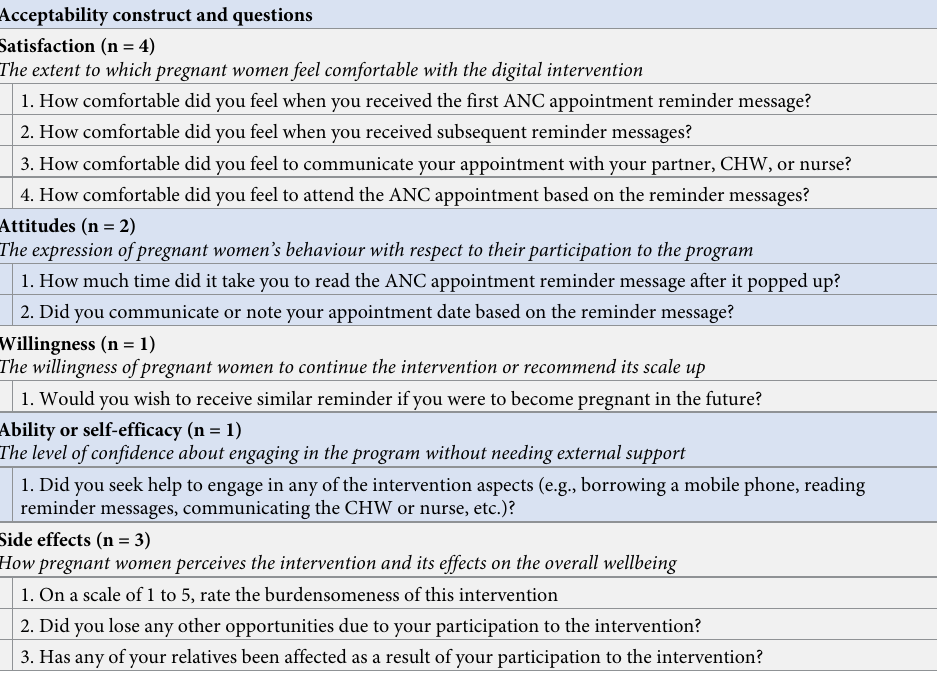
Table 1. Acceptability constructs of the ANC digital